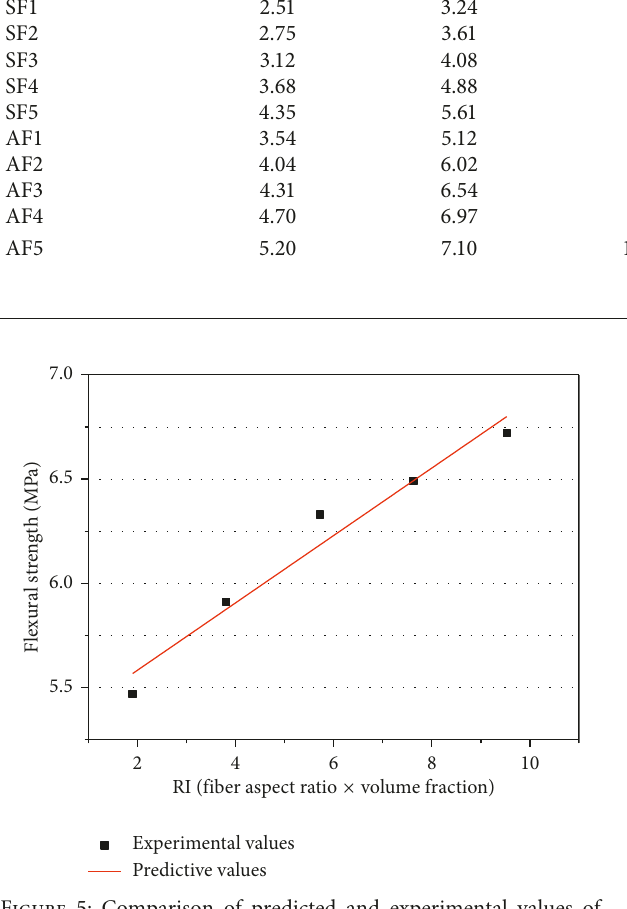
Figure 6: Comparison of predicted and experimental values of compressive